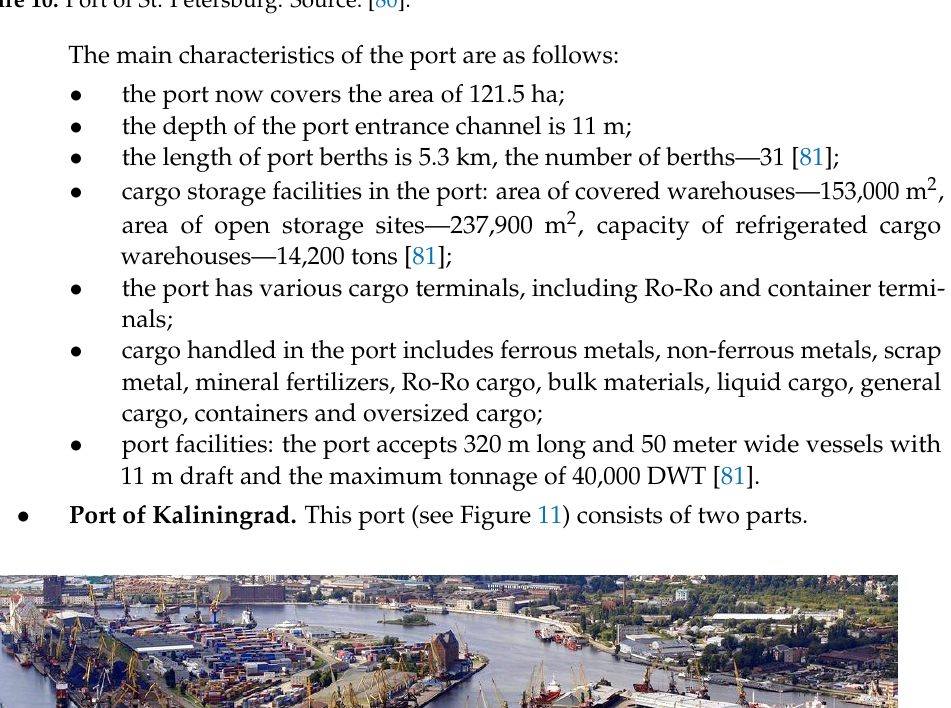
Figure 10. Port of St. Petersburg. Source: [80].